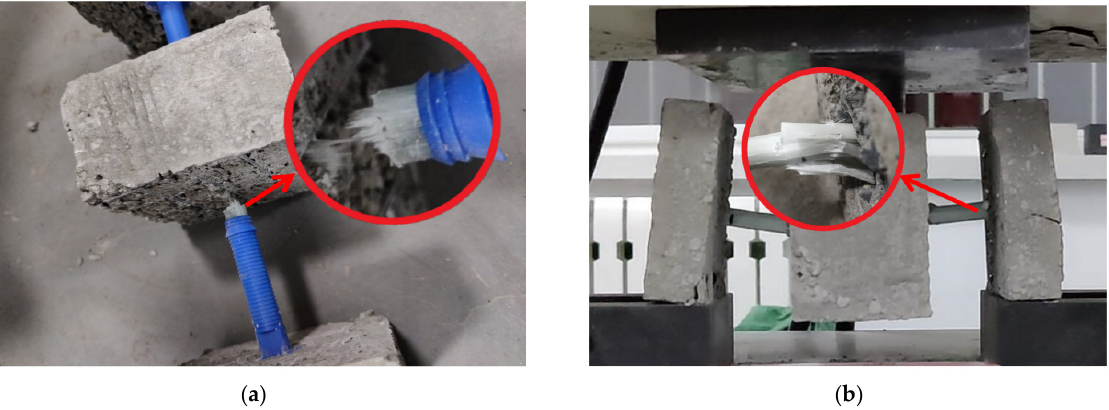
Figure 9. Shear-specimen damage state: ( a ) Damage state of the rod connector; ( b ) Damage state of the claw connector.